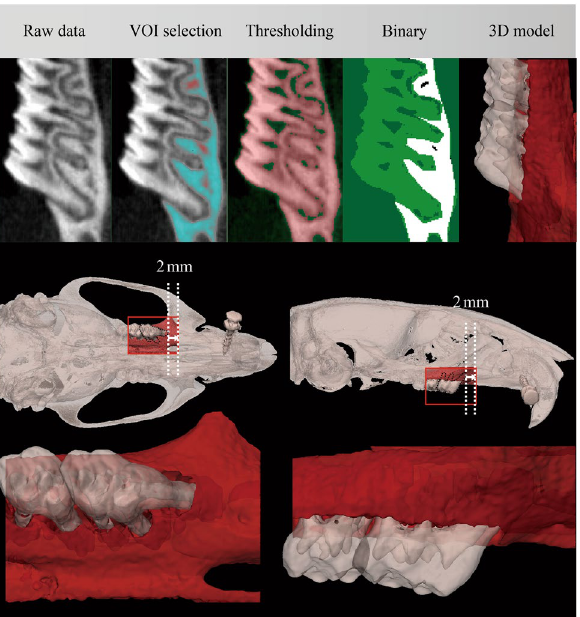
Figure 3. Longitudinal assessment of bone morphometry. The VOIs of the alveolar bone, first and second molar were separately selected and segmented as 3D models on the registered micro-CT in a workflow. The bone morphometry was evaluated in VOIs at each time points and compared